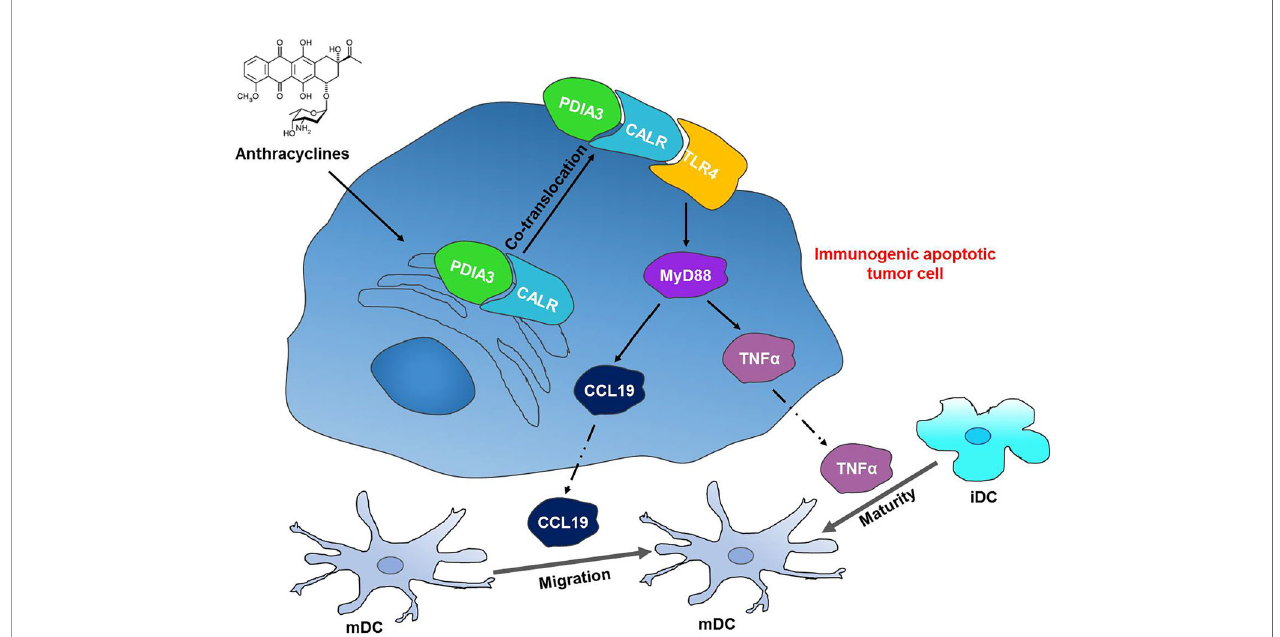
FIGURE 7 | The CALR-TLR4 complex inhibits NSCLC progression by regulating DC migration and maturation and activating anti-tumor immune response. Anthracycline-treated tumor cells form a co-translocation of CALR and PDIA3 from endoplasmic reticulum to cell surface, which causes the interaction between CALR and TLR4. The interaction activates TLR4-MyD88 signaling and promotes the secretion of TNF a and CCL19 and DC in fi ltration and maturation in the tumor tissues, thereby inducing the immunogenic cell death in